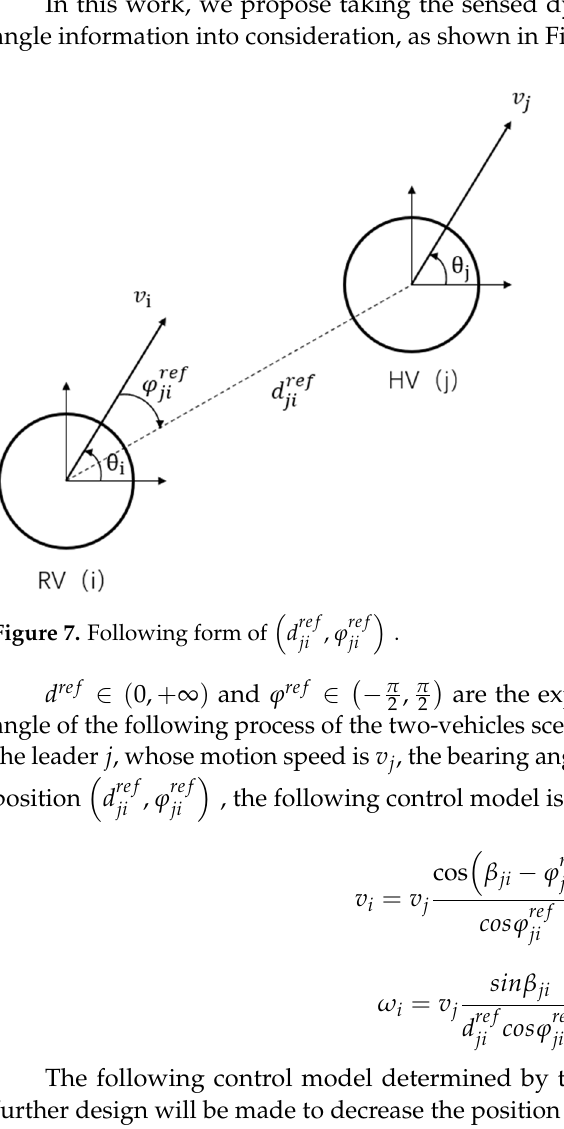
Figure 8. Illustration of the deviation E.   =     −     , (12)   =     −     .